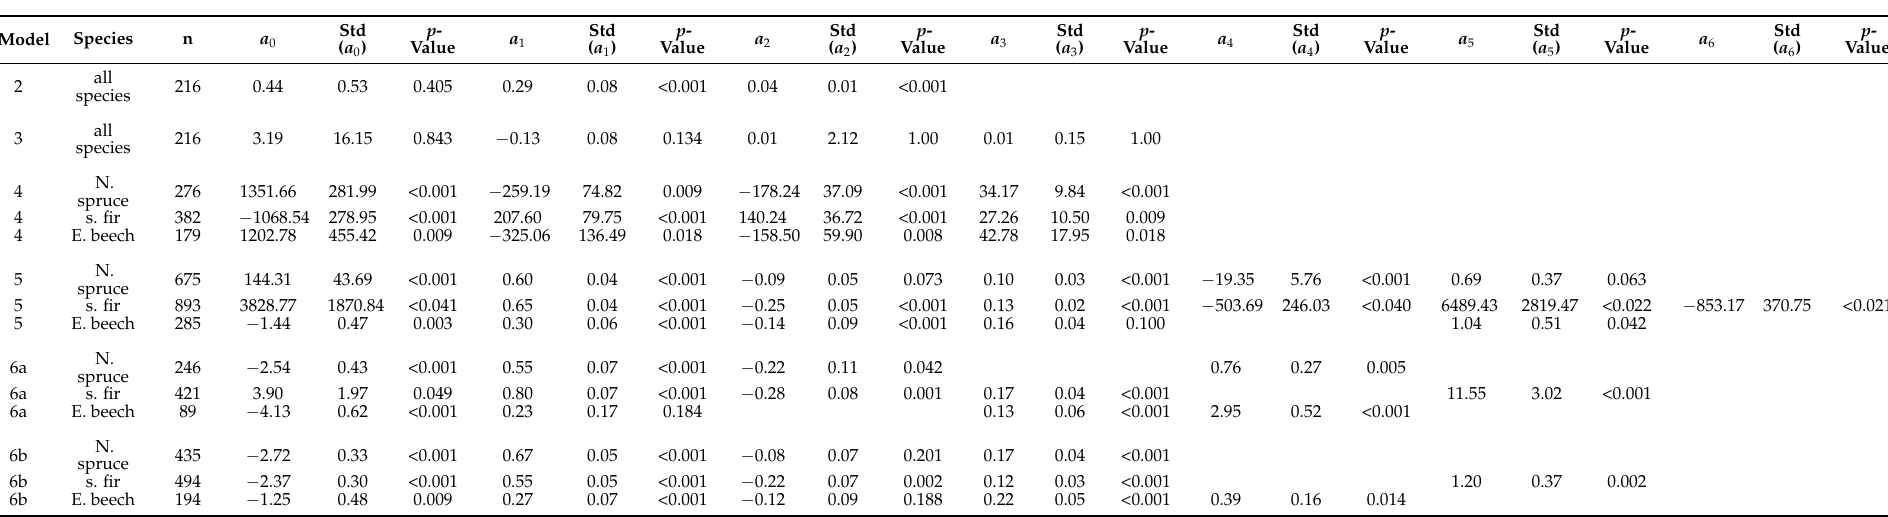
Table 4. Statistical characteristics of the Models 2–6. The model numbers refer to Section 2.4 where the models are introduced in detail. For reasons of space, the table reports just the fixed effect variables of the respective models (Part